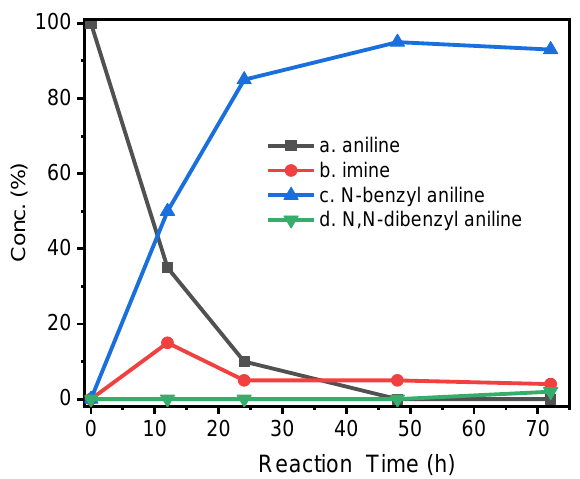
Figure 7. Reaction progress of N-alkylation of aniline. Aniline (1 mmol) reacts with benzyl alcohol (2 mmol) and catalyst (0.018 mmol). Composition distribution of nitrogen-containing products was determined by GC-MS.